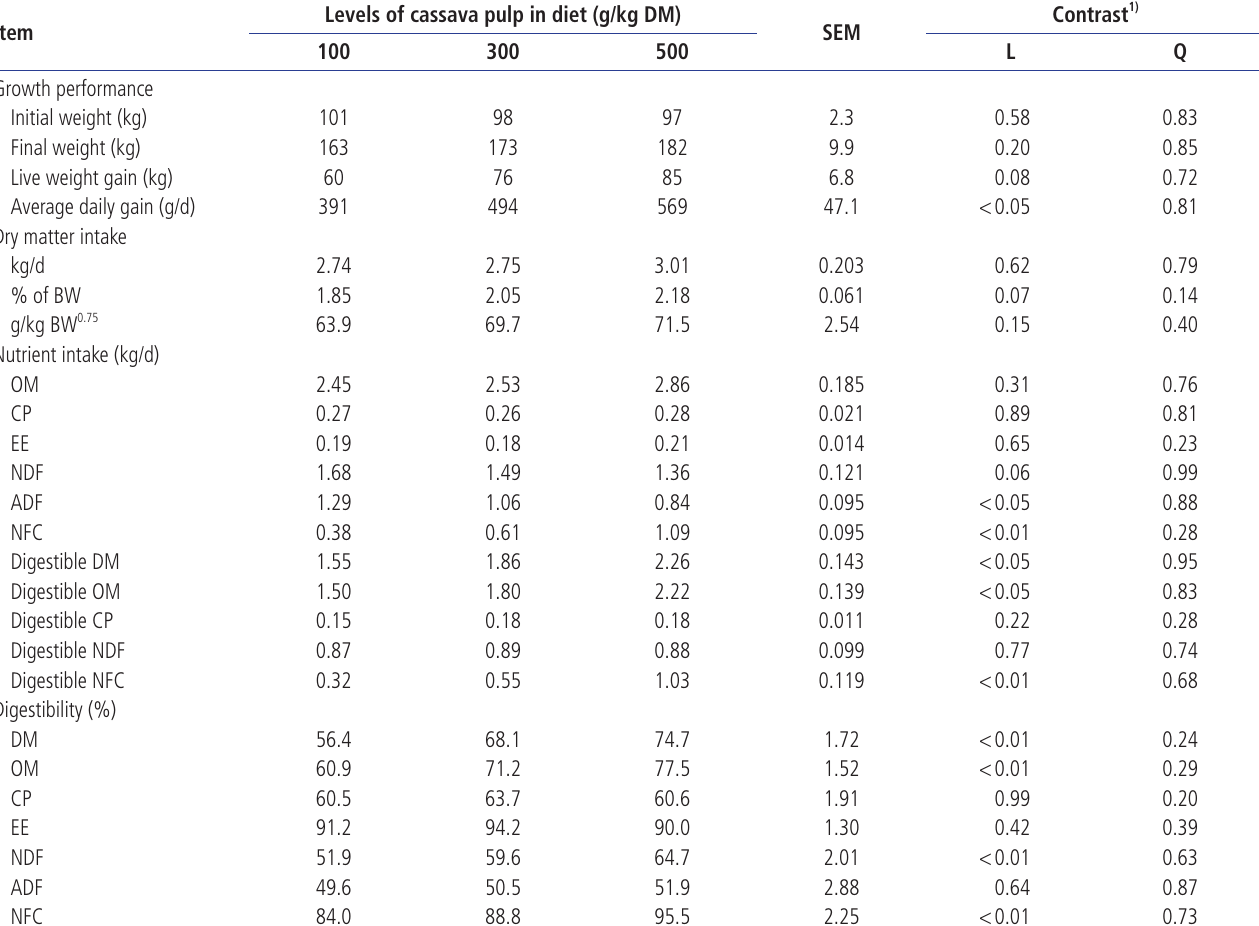
Table 2. Effects of replacing rice straw with cassava pulp in a fermented total mixed ration on growth performance, feed intake and digestibility of Thai native beef cattle